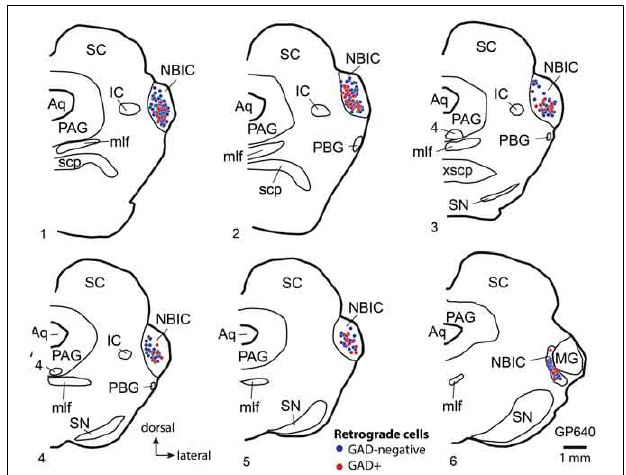
FIGURE 3 | Plots showing the distribution of labeled cells in transverse sections through the right nucleus of the brachium of the inferior colliculus (NBIC) after a large injection of Fast Blue (FB) into the right MG. Each symbol represents one retrogradely-labeled cell. Symbol color indicates whether the FB-labeled cell was GAD-negative (blue circle) or GAD + (red circle). Sections are numbered from rostral to caudal and are spaced 300 µ m apart. See list for